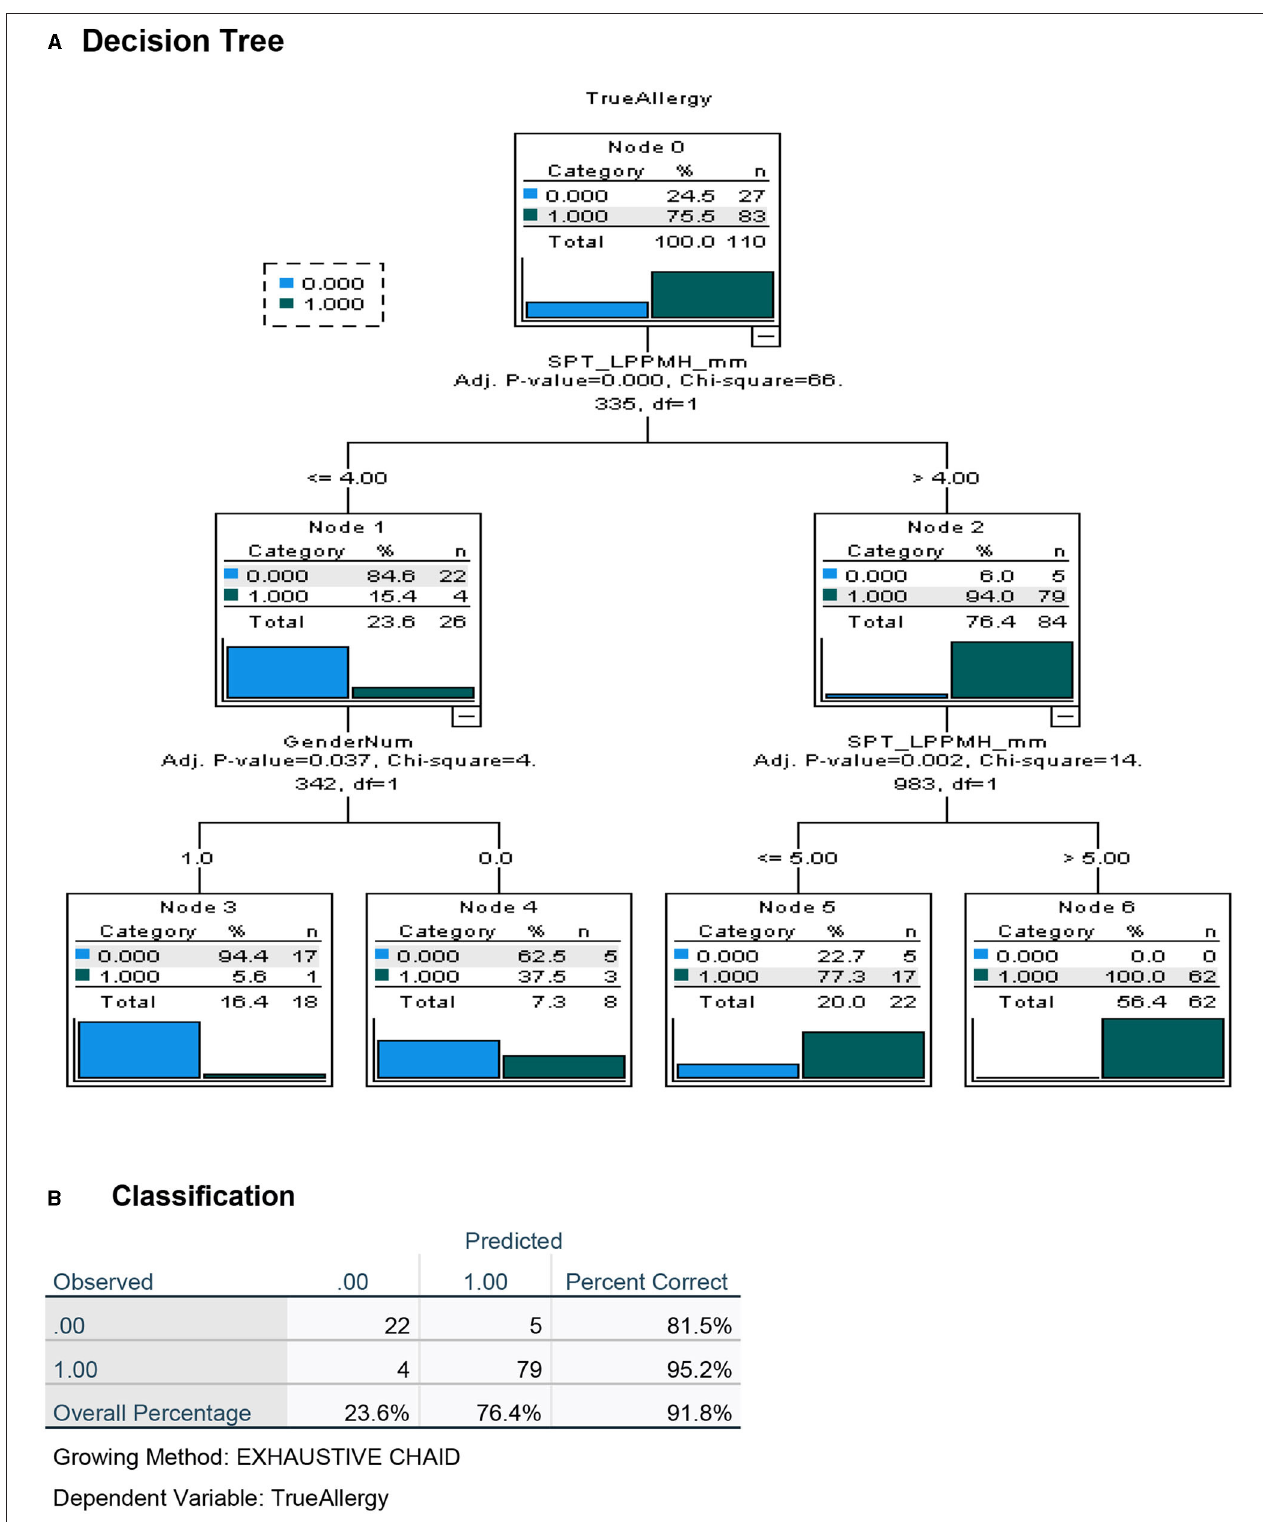
FIGURE 4 | Decision tree analysis for the apriori (before challenge) classification of Peanut Allergy (PA) and Peanut Tolerance (PT) in high risk preschoolers using results of the LPP-MH prick tests. (A) Decision tree and (B) Classification table.